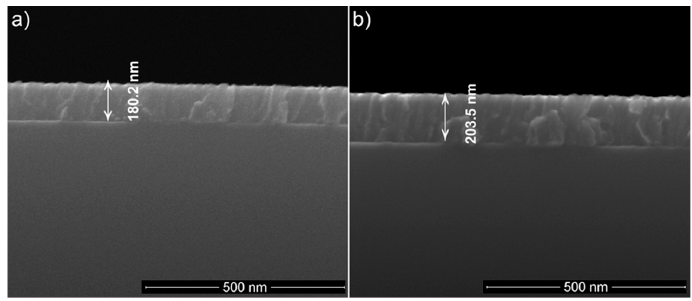
Figure 7. The thickness of the Ag:HAp-S1 ( a ) and Ag:HAp-S2 ( b ) composite layers.